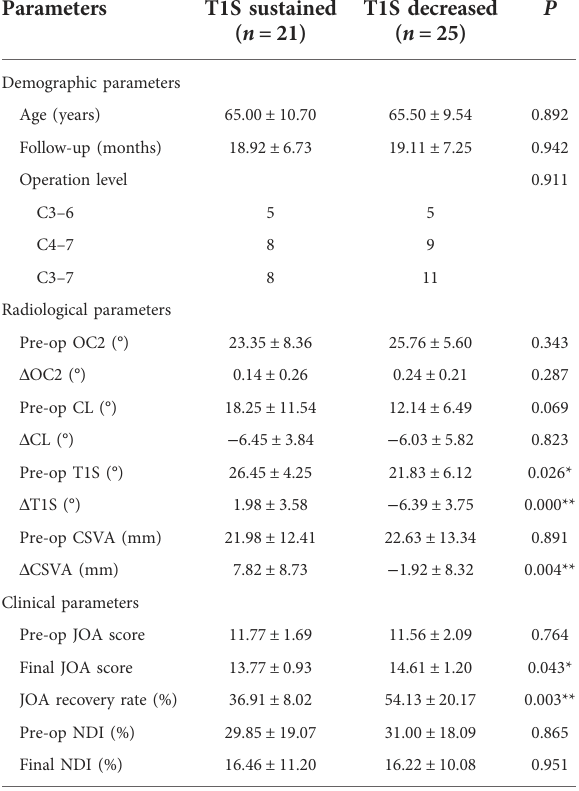
TABLE 4 Comparison of radiological parameters and clinical parameters between the T1S sustained subgroup and the T1S decreased